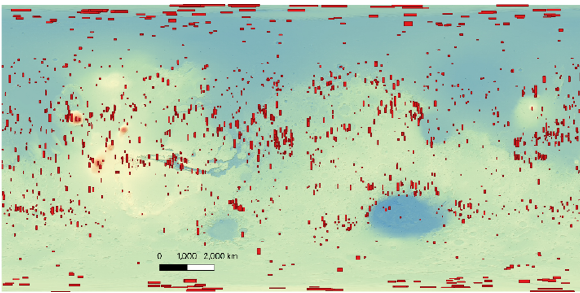
Figure 7. Distribution of 2,375 CTX 3D 18m DTM and 6m ORI products covering the Martian surface.